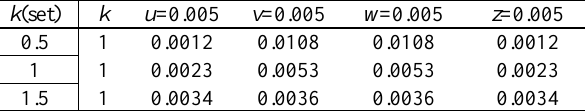
Table 1. Ainsworth calibration results